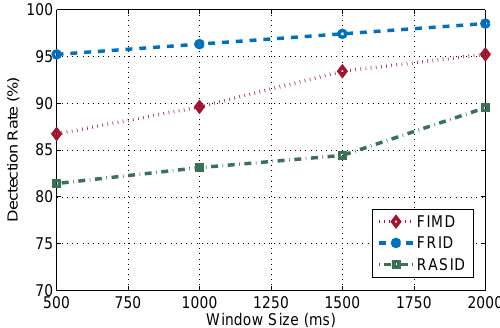
Figure 15. The performance of different DfP systems.